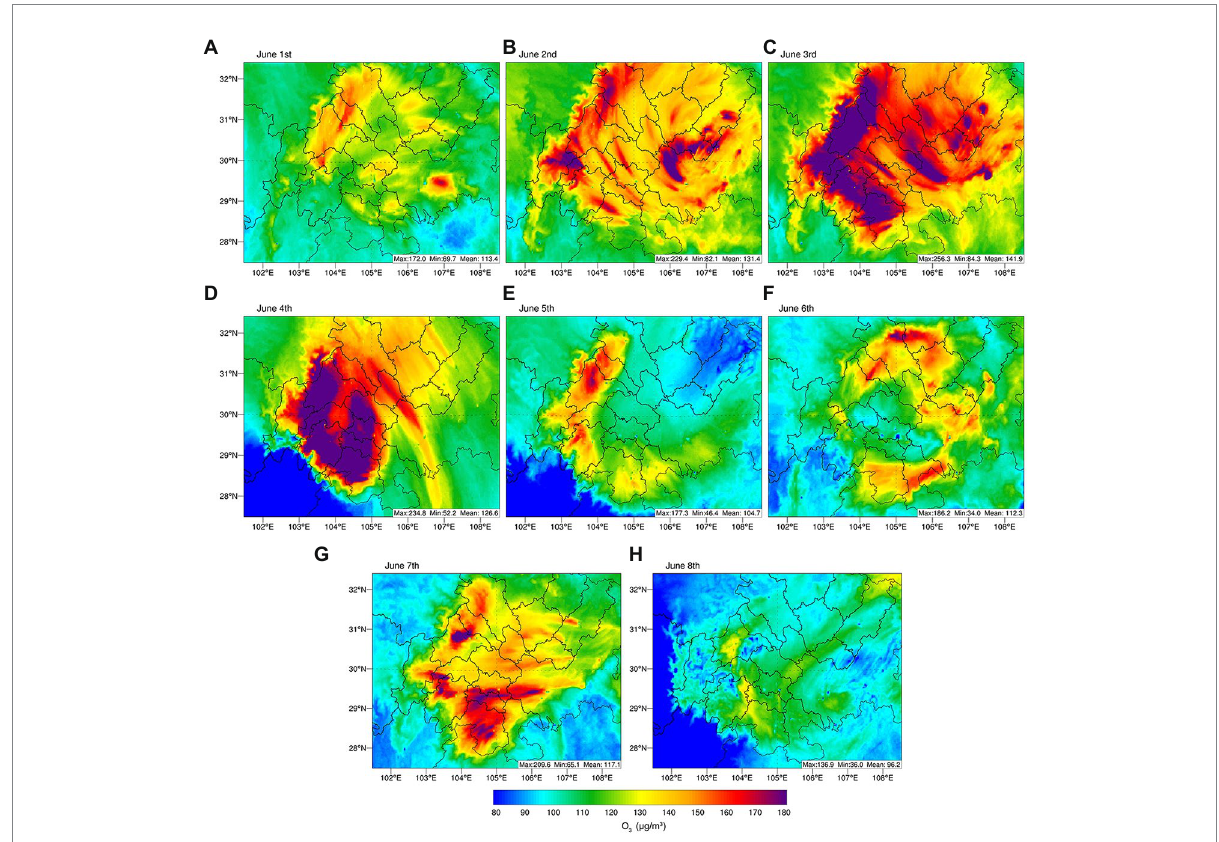
FIGURE 3 (A-H) Spatial map of ground-level MDA8 O 3 concentrations over the SCB from 1 June to 8 June,